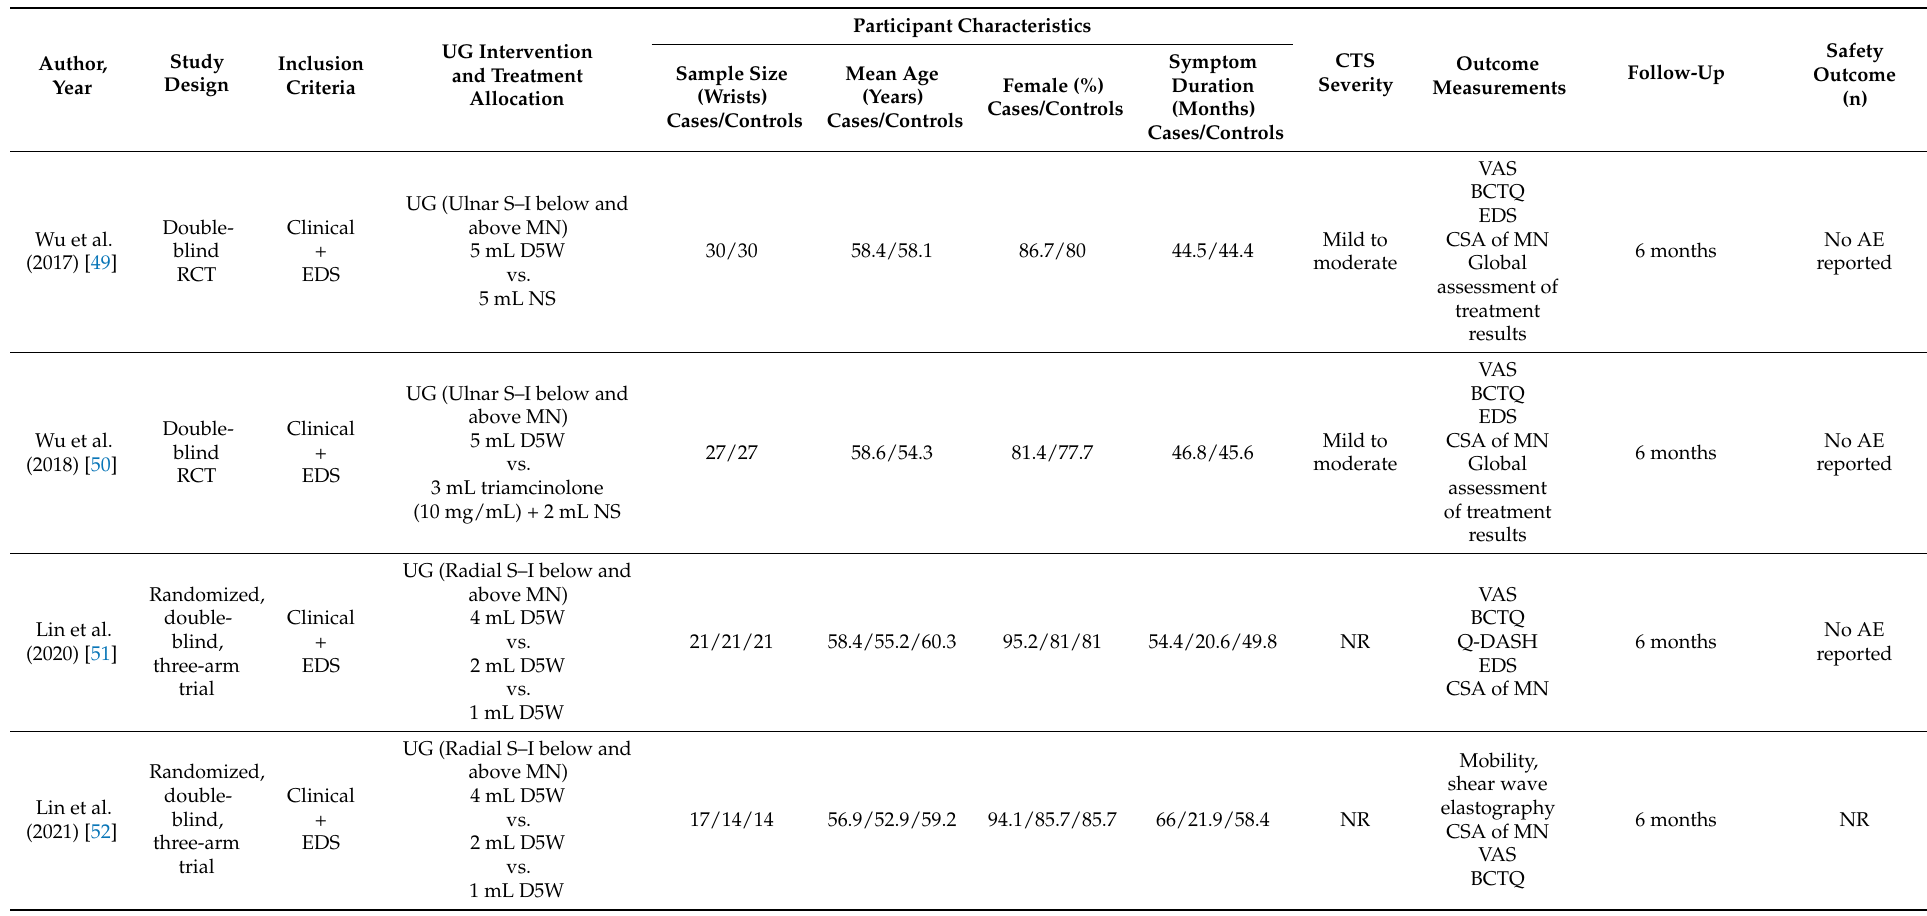
Table 5. Intervention details of included studies using ultrasound-guided D5W injection for treating carpal tunnel